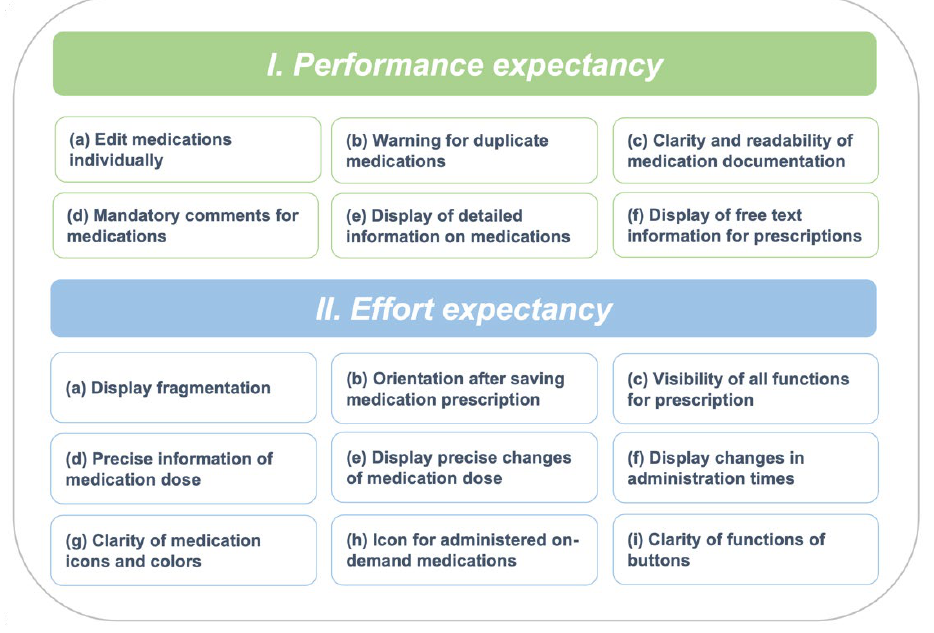
Figure 4. Categories and subcategories from the qualitative content analysis.